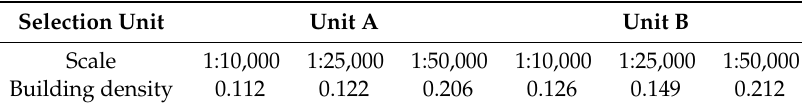
Table 3. Density information at different